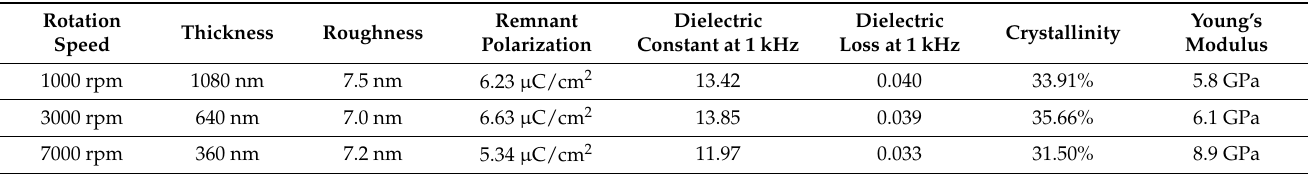
Table 2. Rotational speed-dependent physical properties of P(VDF-TrFE) films during the spin coating. The distance from the center was fixed at 4